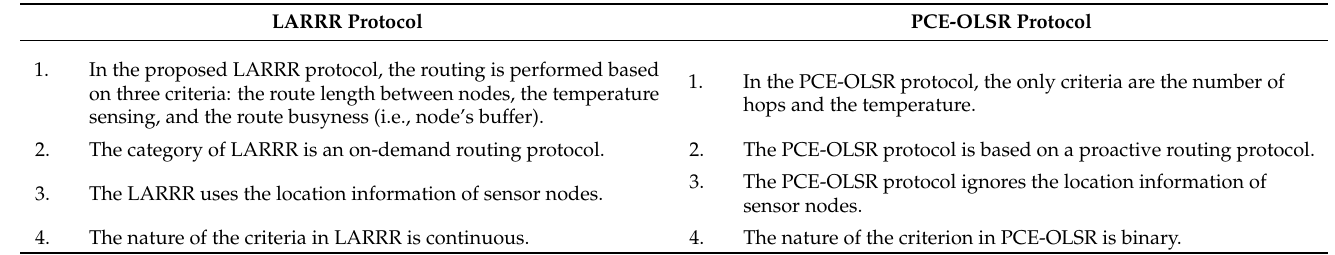
Table 2. Comparison of the methodology between the proposed LARRR and